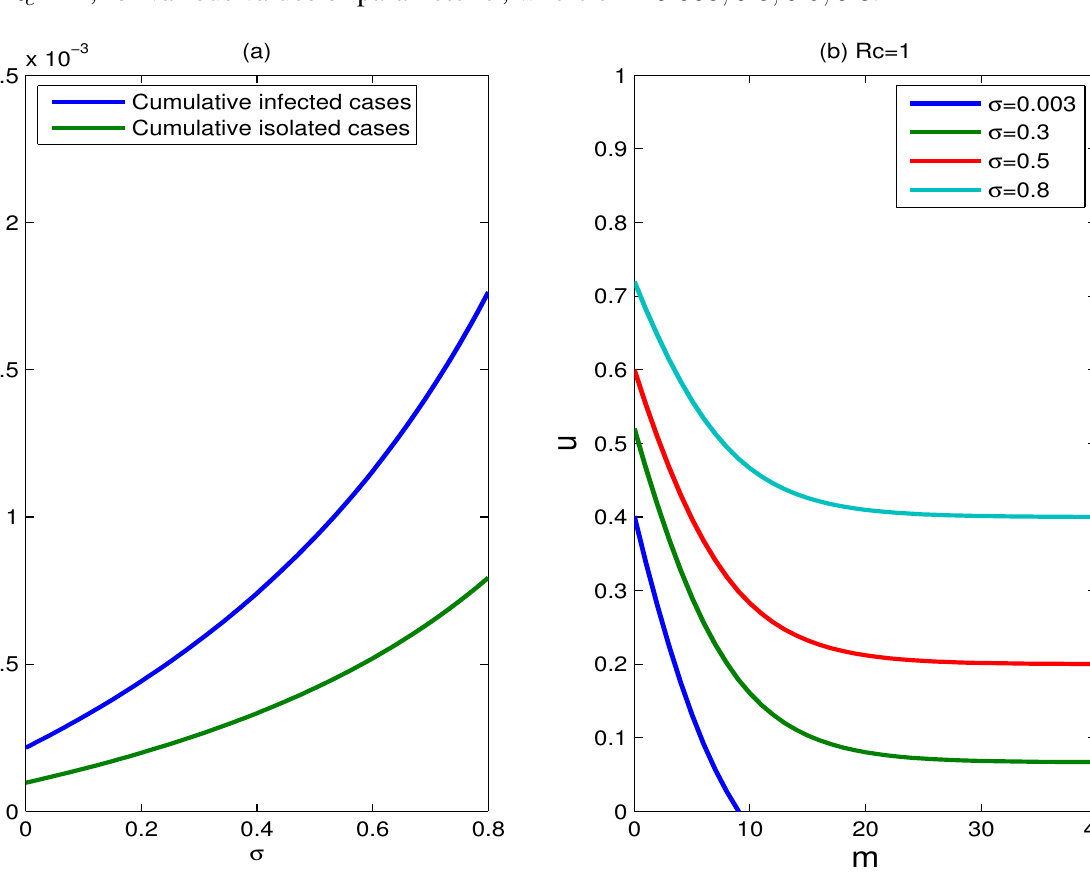
Figure 9. The effect of the relative infectivity of asymptomatic cases. ( a ) Plots of the cumulative percentages of infected individuals and isolated cases as functions of the parameter σ , for a duration of six months, where u = 0 . 9 , m = 15 ; ( b ) plots for